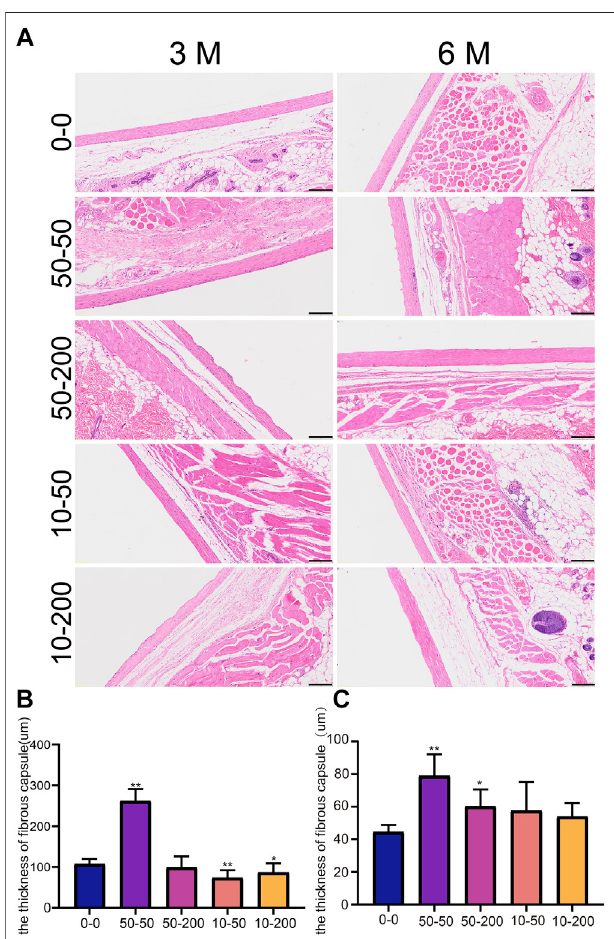
FIGURE 9 | Effect of surface topology on capsule tissue. (A) HE staining results of capsule tissue after 3 and 6 months of subcutaneous -implantation of materials in rats. (B) Statistical results of capsule thickness at 3 month. (C) Statistical results of capsule thickness at 6 month. Data comparisons wereimplemented utilizingone-wayANOVA, and the valuesare expressed as mean ± standard deviation (SD). n (cid:2) 10, * p < 0.05, ** p < 0.01 vs 0-0.